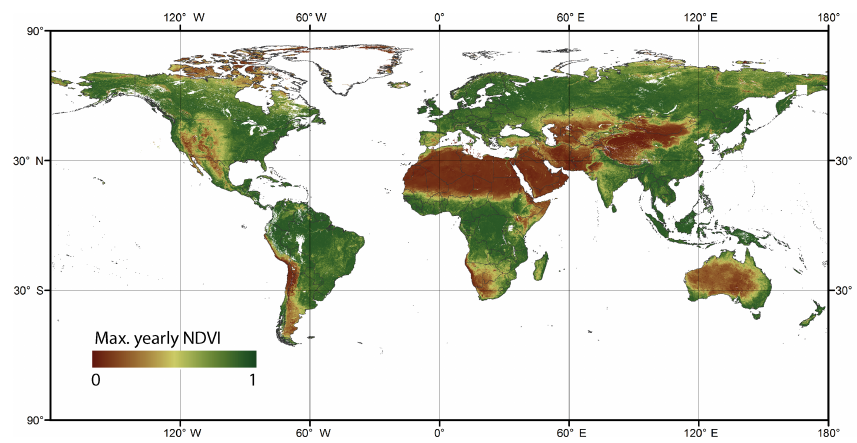
Figure 2. Yearly maximum NDVI derived from maximum bimonthly NDVI data of the EnviSAT MERIS instrument. Table 1. Applied global data